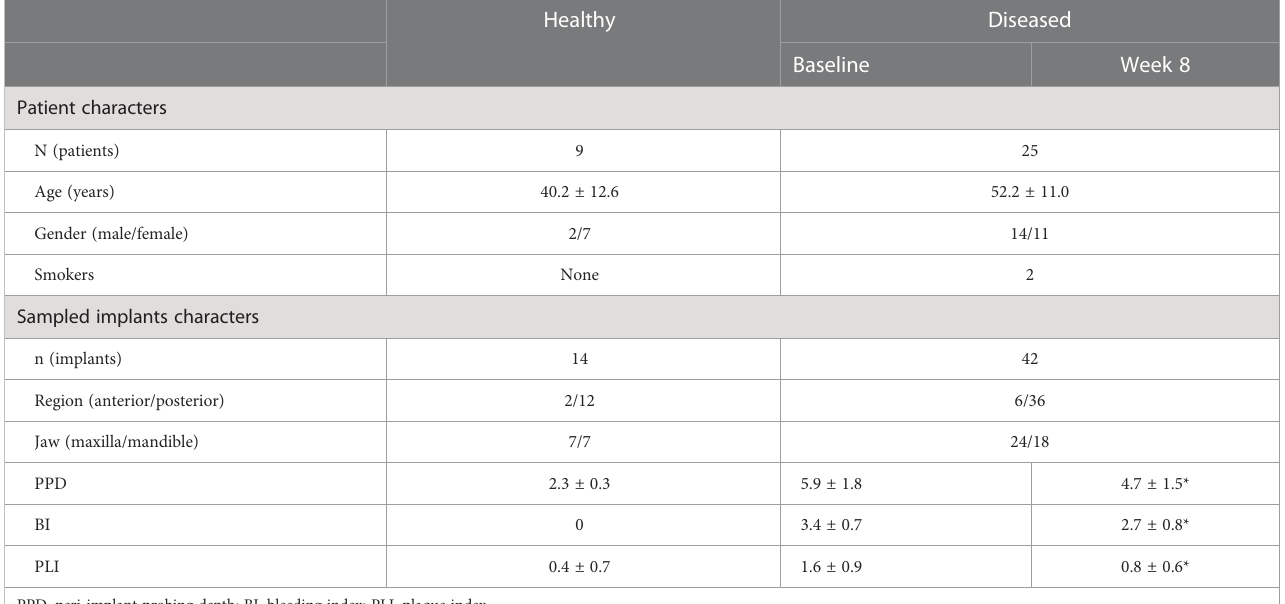
TABLE 1 Demographic and clinical characteristics of study participants.